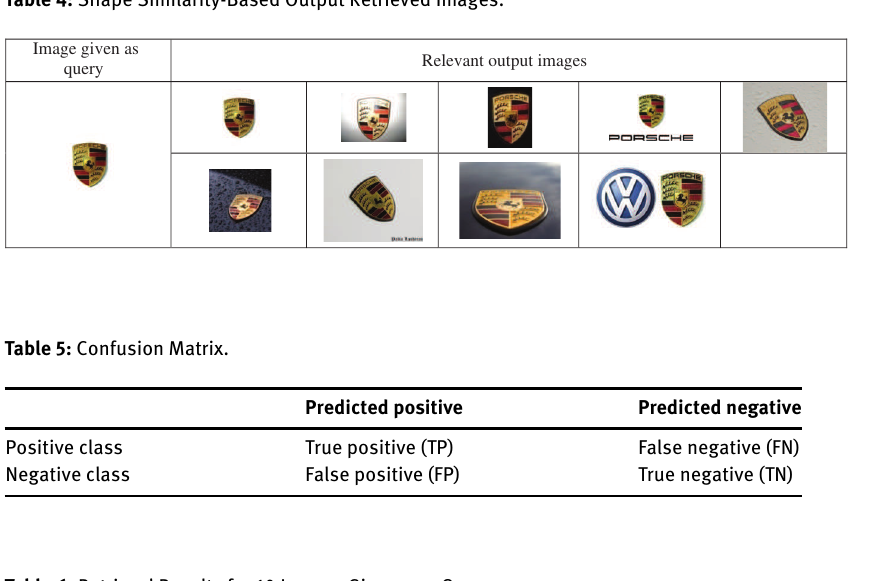
Table 6: Retrieval Results for 10 Images Given as a Query. S.